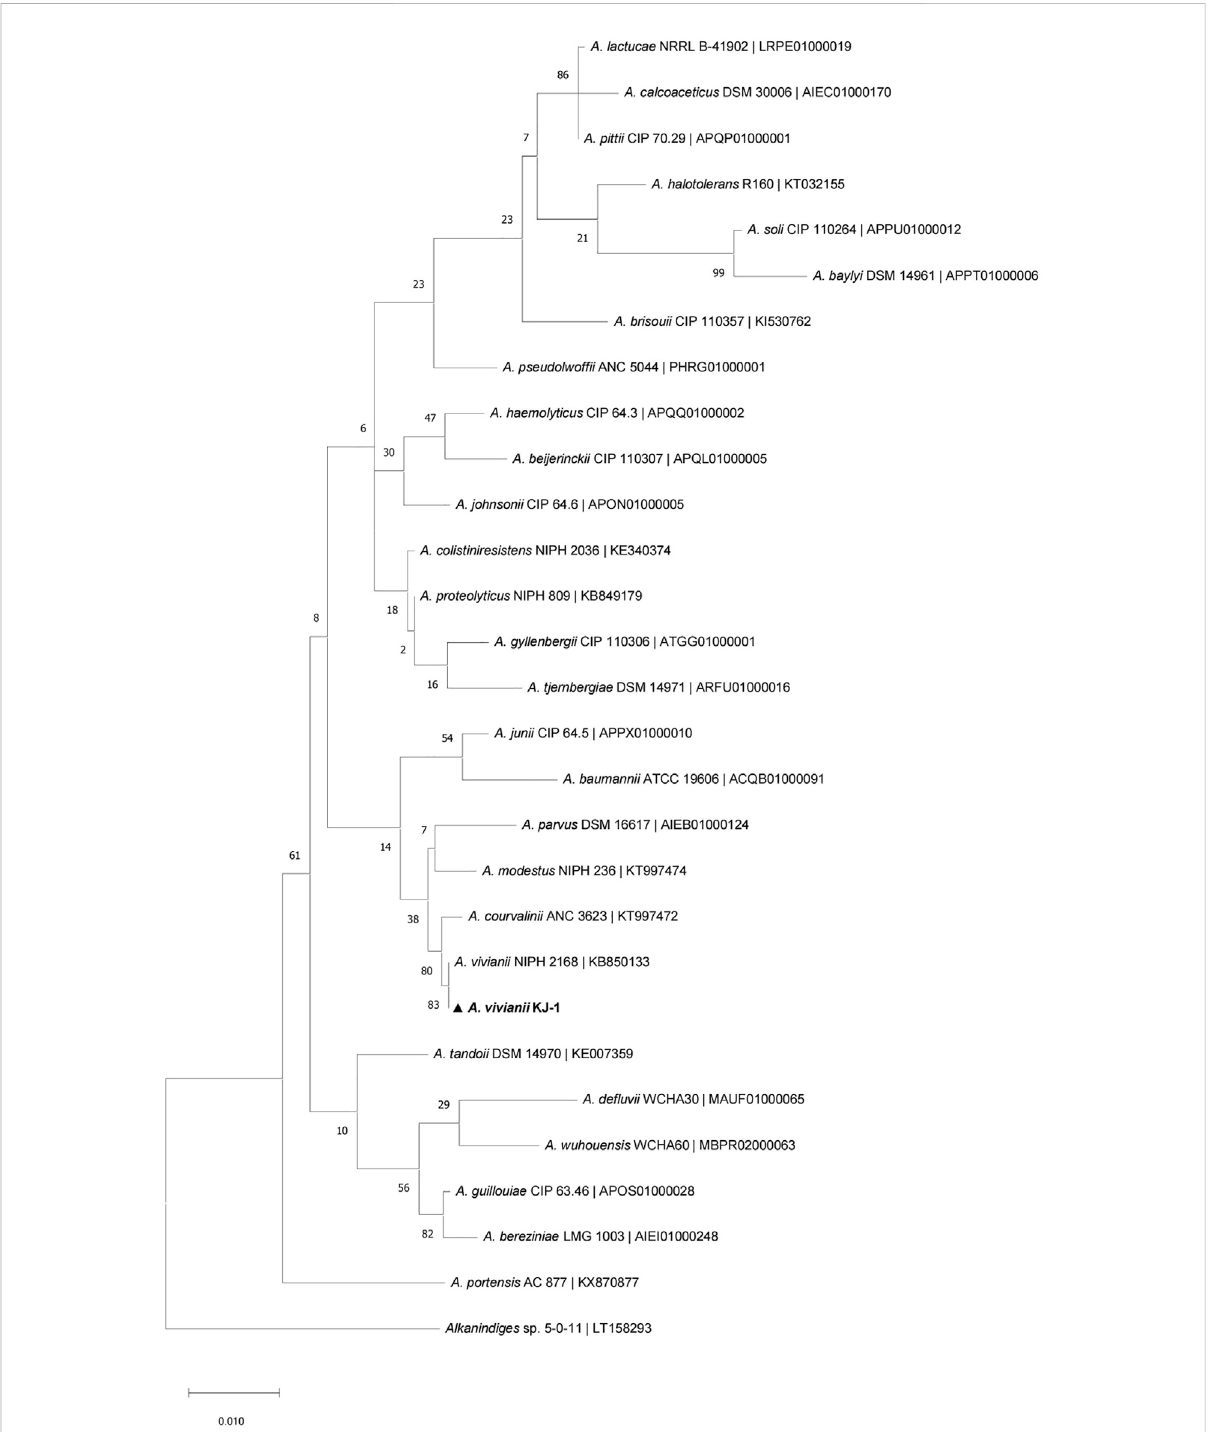
FIGURE 2 Phylogenetic tree of Acinetobacter sp. KJ-1 and its closest related species based on 16S rRNA gene sequence similarity using maximum likelihood method. Data for all 16S rRNA genes were downloaded from NCBI (http://www.ncbi.nlm.nih.gov). The outgroup used was Alkanindiges sp. 5-0-11. Bootstrap value represents 1,000 replicates and random seeding. Tree was built using Mega